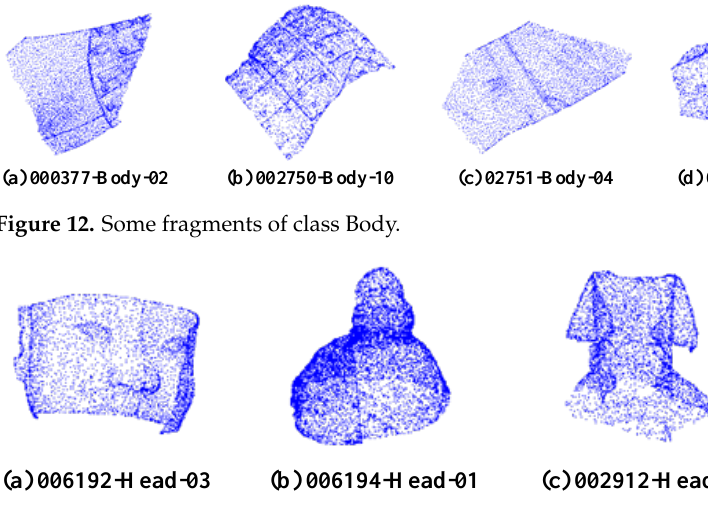
Figure 13. Some fragments of class Head.